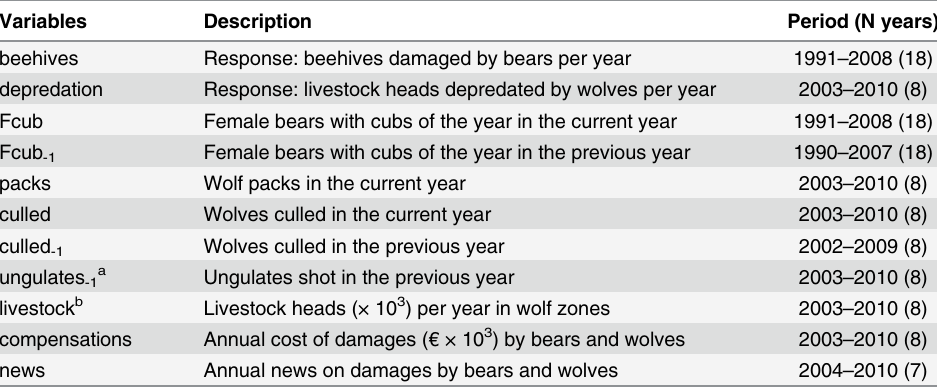
Table 1. Variables used in the study.